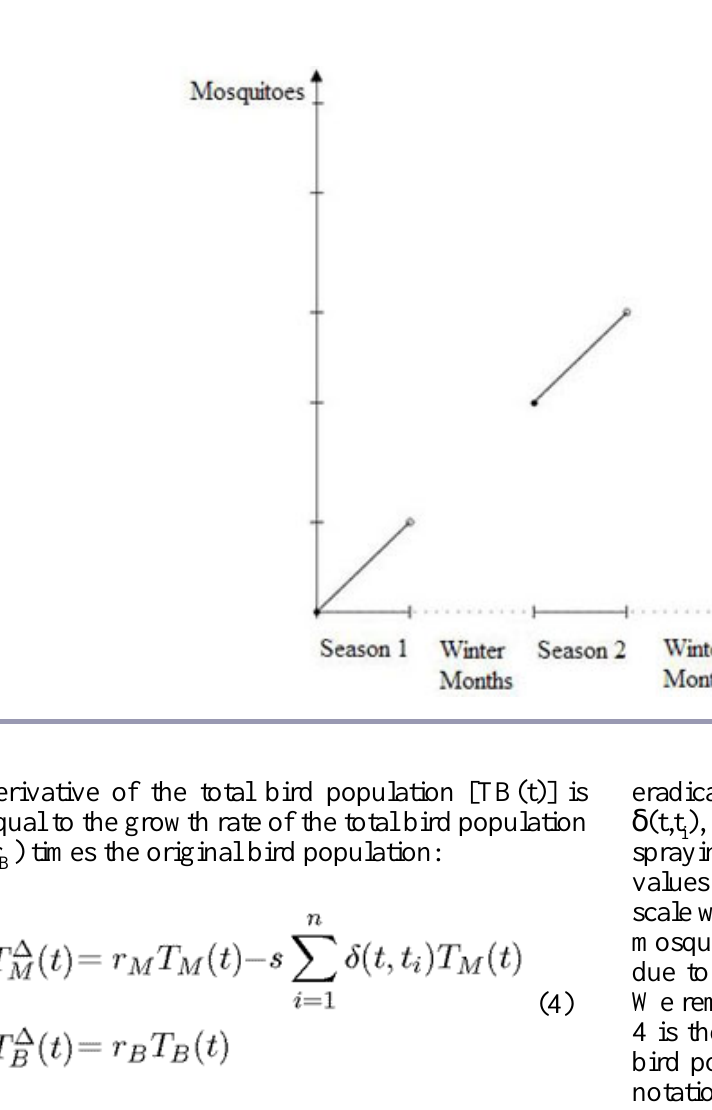
Fig. 3. A schematic diagram depicting mosquito population growth (vertical axis) as a function of a seasonal time scale (horizontal axis) where the active mosquito population remains dormant during